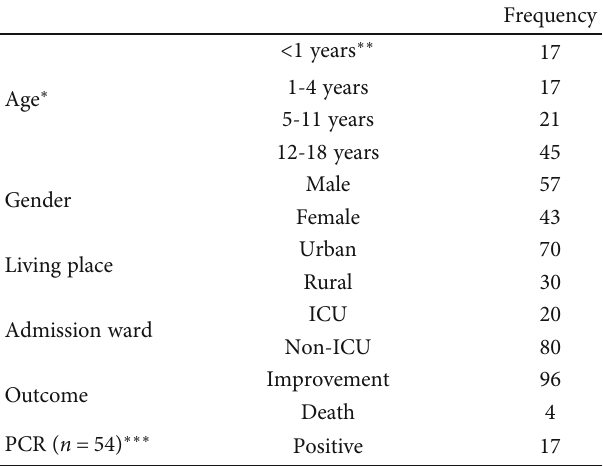
Table 1: Demographic data and clinical characteristics of the children with COVID-19 ( N = 100 ).